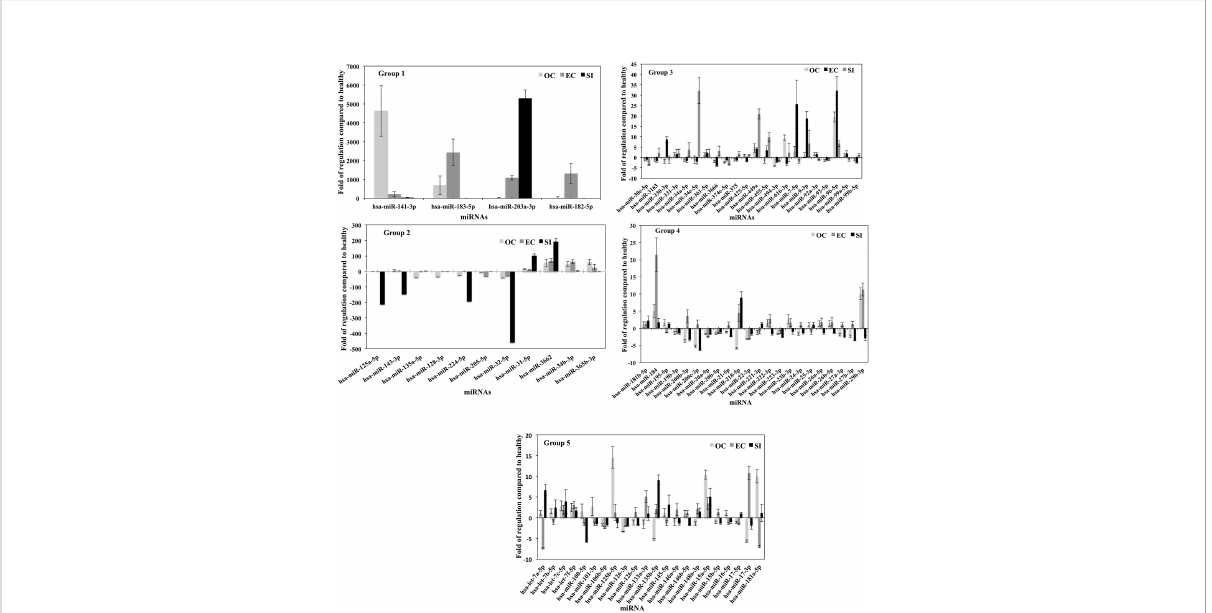
FIGURE 5 miRNA pro fi le of plasma vesicles showing the folds of regulation in the expression of speci fi c miRNAs compared to healthy subjects. Three plasma samples from each of the three PC tumor types (OC, EC, and SI) were compared to three healthy subjects, and the results were normalized to a set of control miRNAs included in the microarray. The fi ve groups (histograms) have various regulation scales to differentiate between miRNAs that are moderately differentially expressed to those that are greatly differentially expressed. P-values were calculated based on a Student ’ s t-test of the replicate 2^(- Delta Ct) values for each gene in the control group and treatment groups, and p < 0.05 was used to consider the fold of regulation to be signi fi cant. The results were presented as the mean ±